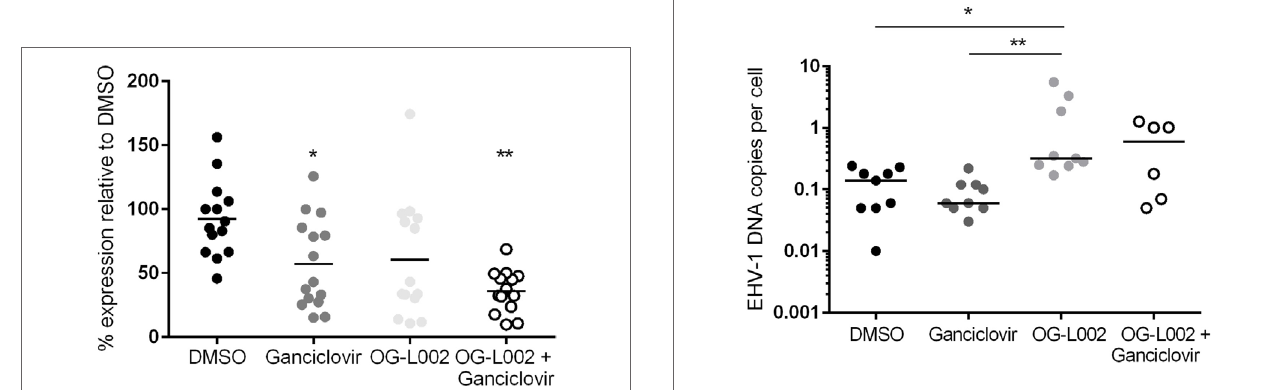
FigUre 4 | Effect of treatment on equine herpesvirus type 1 (EHV-1) IE gene expression during lytic infection of primary equine fetal kidney cells. EHV-1 IE gene expression was decreased in the presence of ganciclovir (* p = 0.04) and combined treatment of ganciclovir and OG-L002 (** p = 0.0003) at 3 hpi, when compared with DMSO control vehicle. Lines represent mean values.